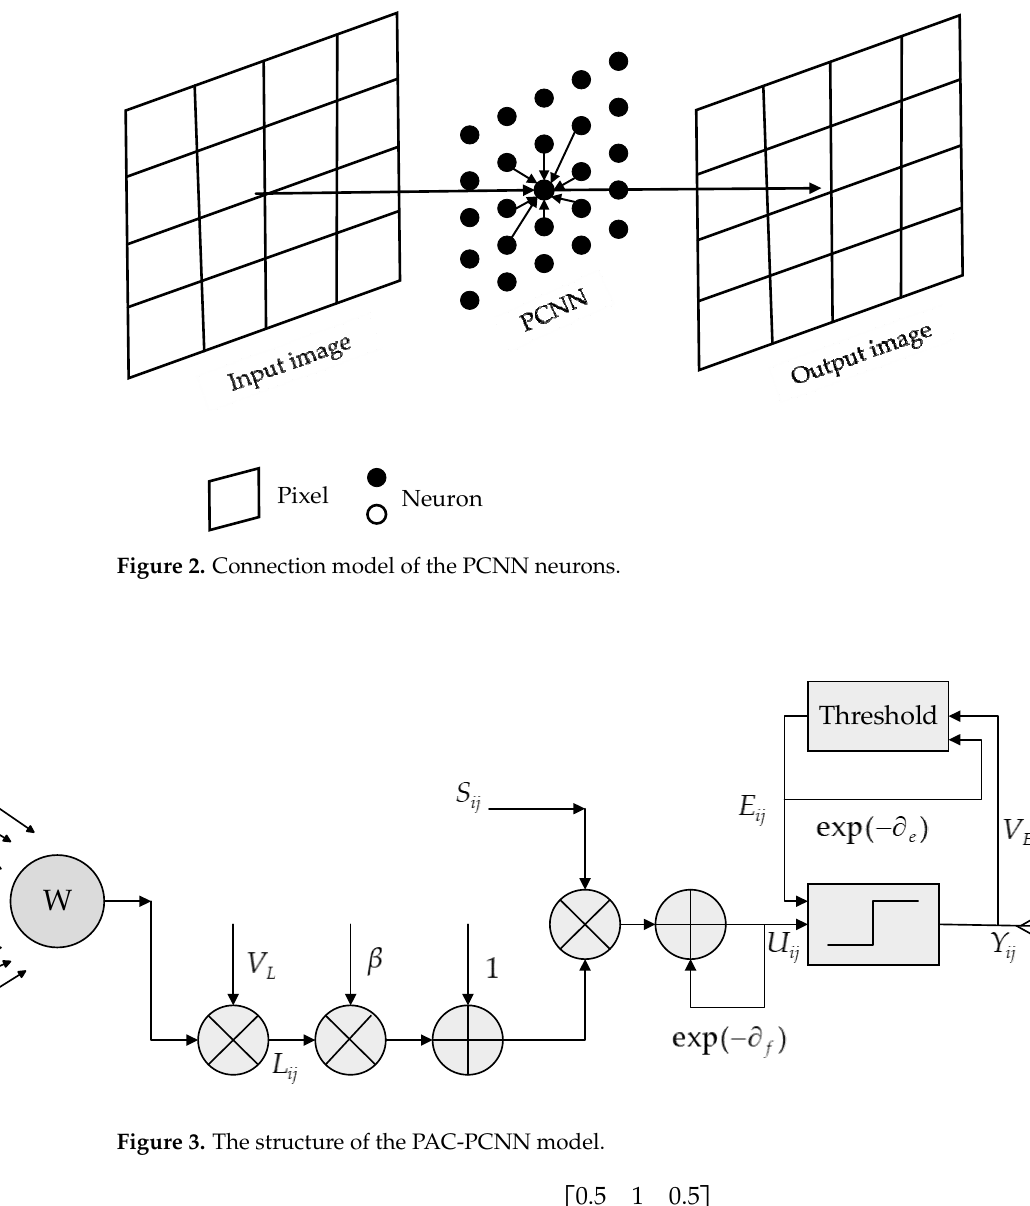
Figure 3. The structure of the PAC-PCNN model. In the above PAC-PCNN model,